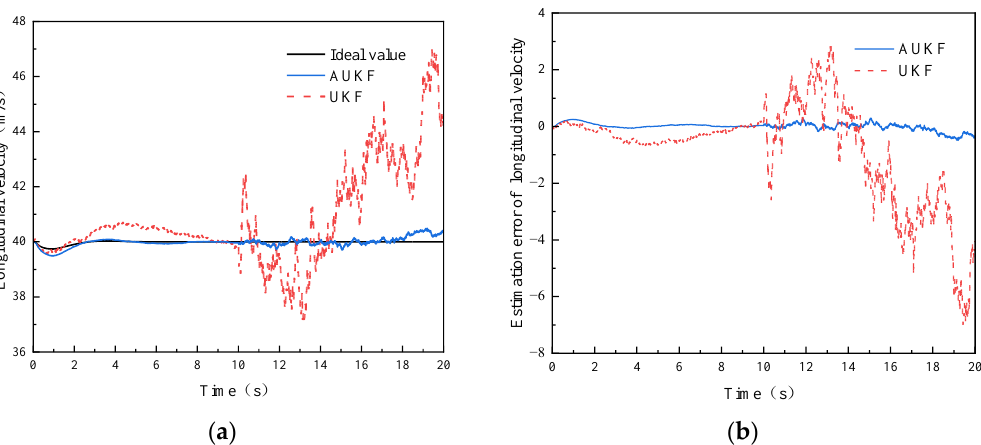
Figure 11. Simulation results of longitudinal velocity. ( a ) Comparison of estimated results and ( b ) comparison of estimated error.